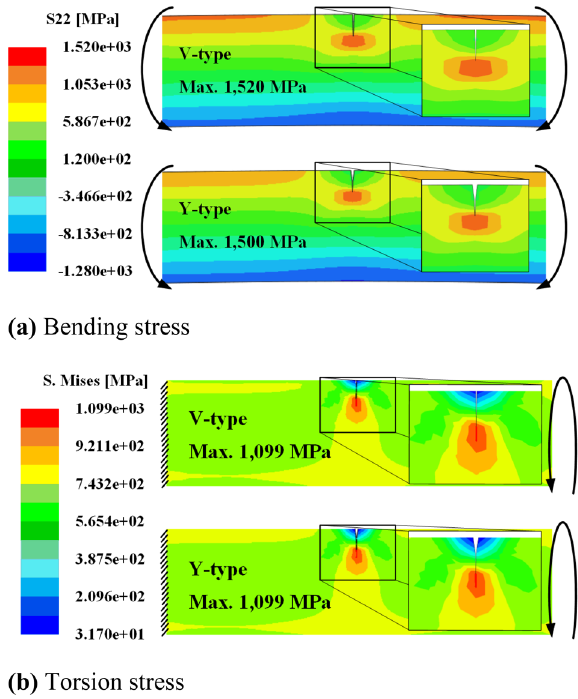
Figure 7. Effective stress distribution in a 2D model with Y-type and V-type surface flaws.